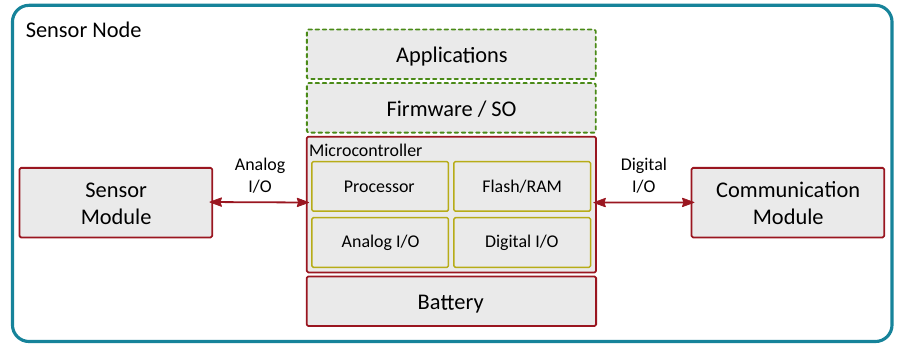
Figure 12. Mobile sensor